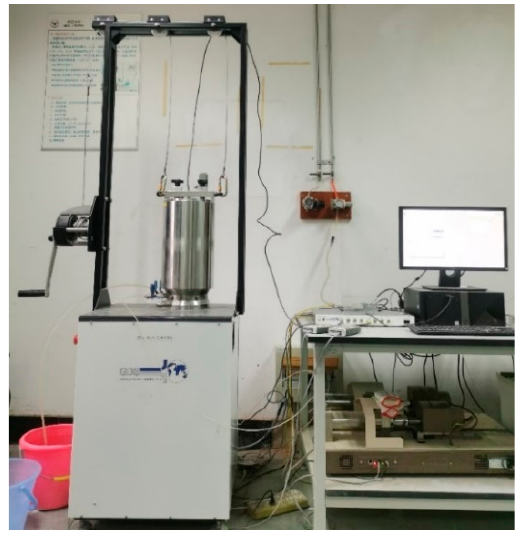
Figure 2. Photograph of GDS triaxial shear apparatus.